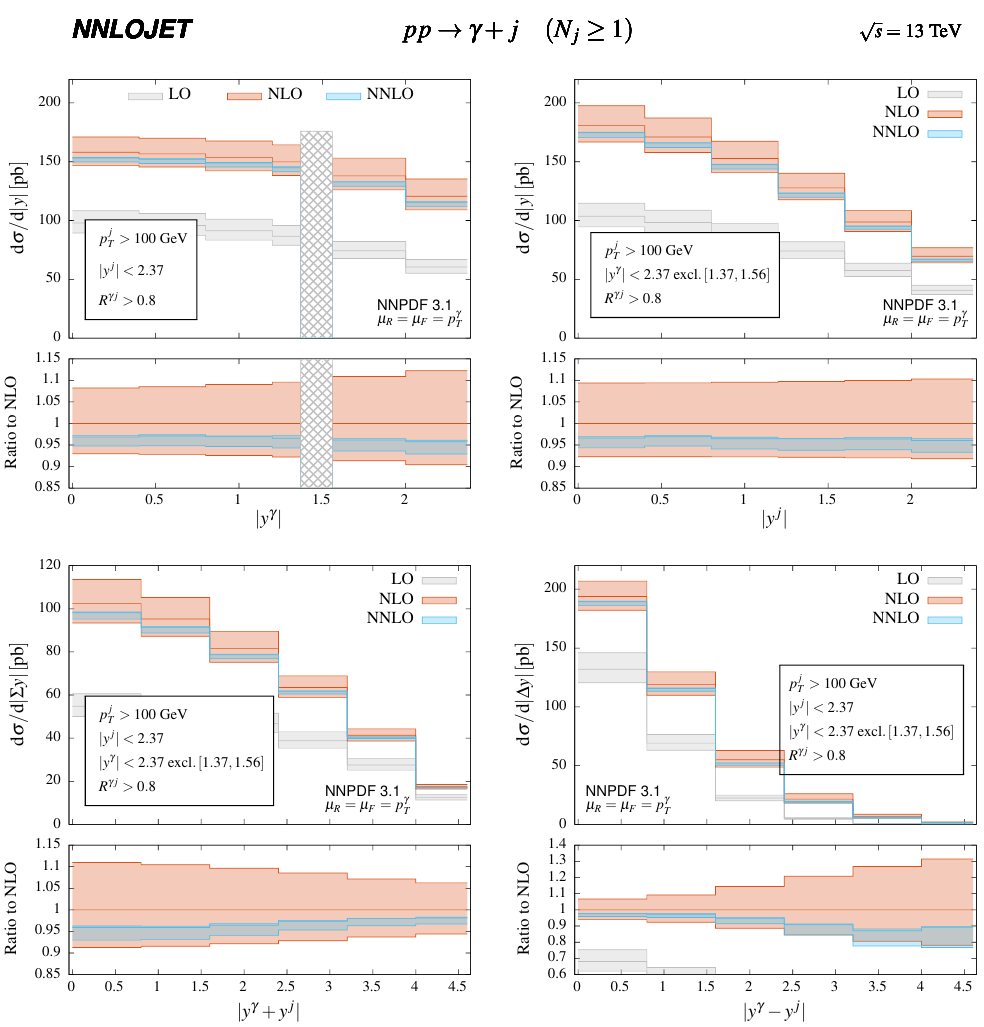
Figure 16 . Rapidity distribution of the photon (top left), of the leading jet (top right), distribution of the rapidity sum of both (bottom left) and of the rapidity di(cid:11)erence (bottom right), at LO, NLO and